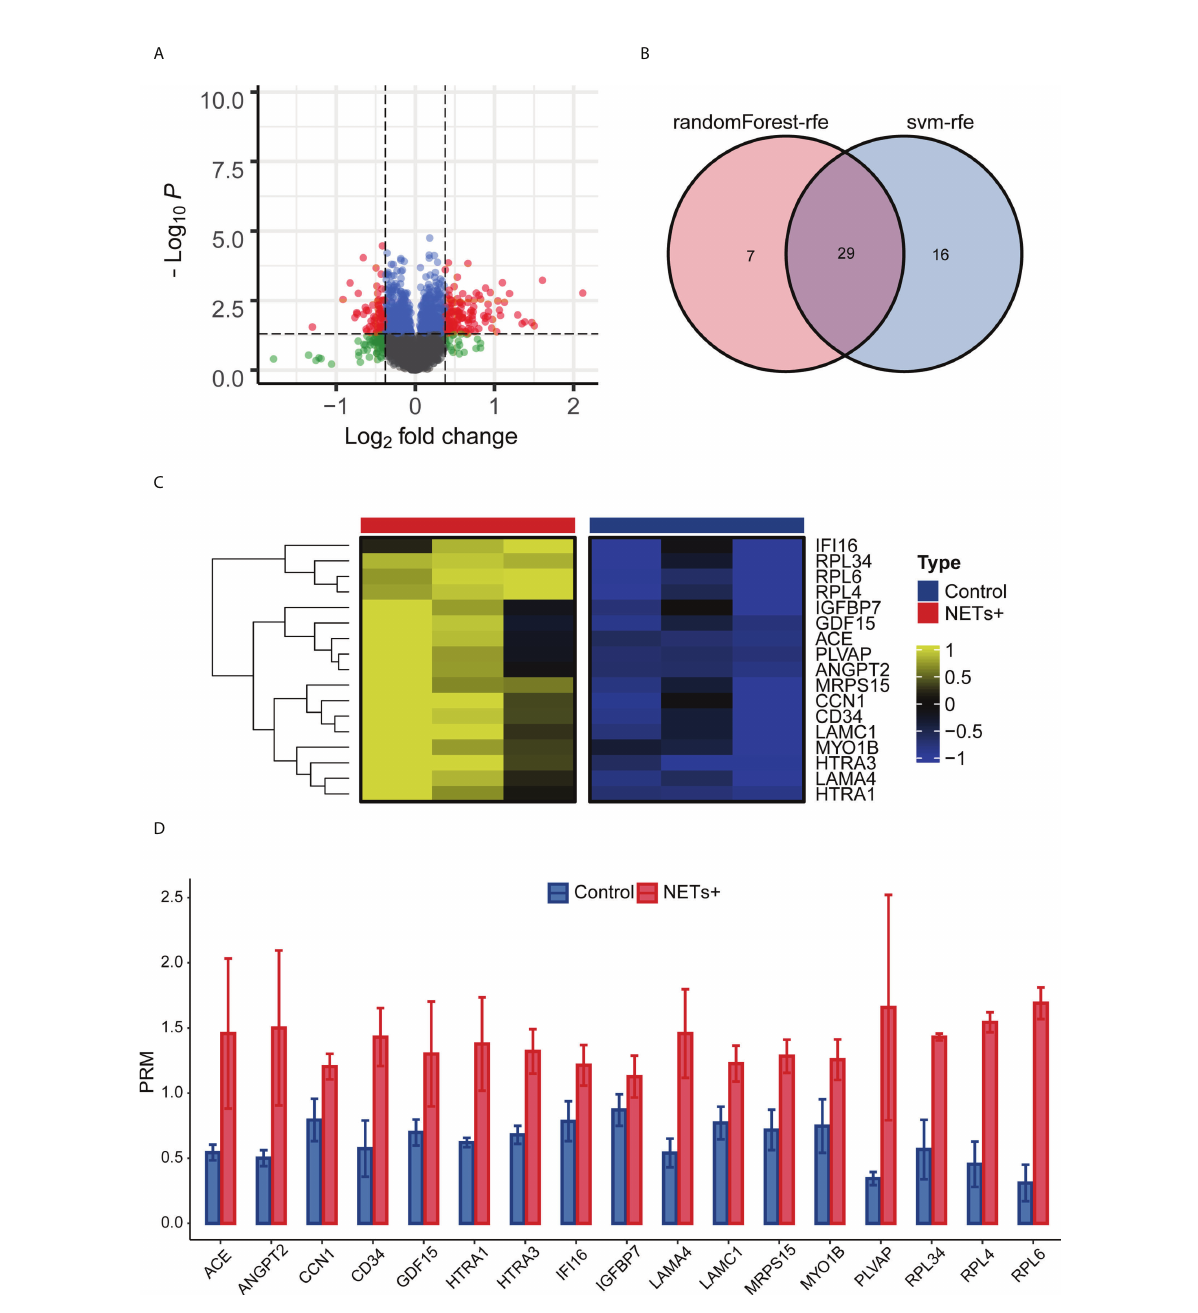
FIGURE 2 Screening ANGPT 2 based on TMT-MS/MS data and PRM analysis. (A) Volcanic map of the results of NETs + vs. Control difference analysis. (B) Svm-rfe and randomForest-rfe reduce dimensionality based on up-regulating differential proteins. (C) PRM analysis heat map of 17 differential proteins. (D) Analysis of bar plot by PRM of 17 differential